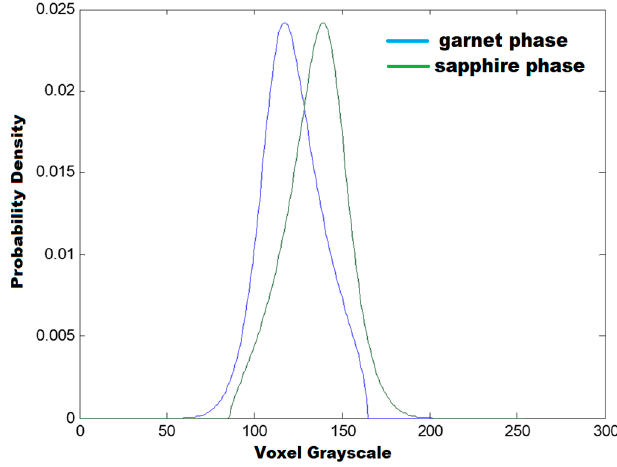
Figure 5. Graphs of the calculated density function in two subsets of voxels, corresponding to YAG (white) and sapphire (gray) phases in the microtomography image presented in Figure 4a for sample 2.